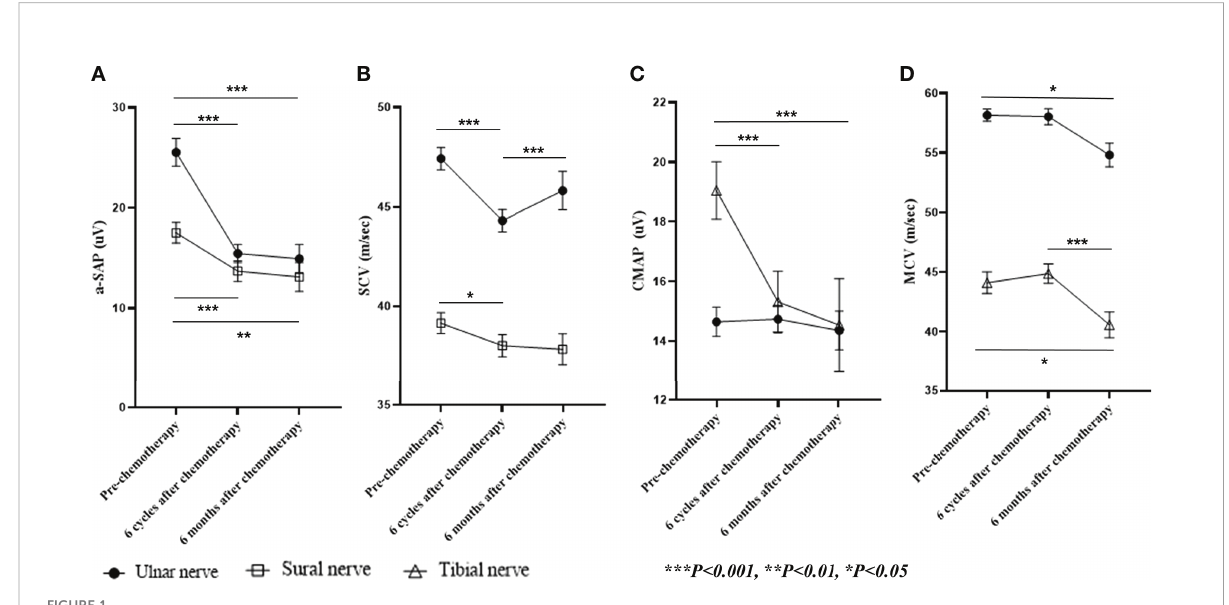
FIGURE 1 Nerve conduction studies. Shown are (A) a-SAP, (B) SCV in the ulnar and sural nerves, (C) CMAP, (D) MCV in the ulnar and tibial nerves during and six months after paclitaxel treatment. Data are presented as mean ± standard error. a-SAP, amplitude of the sensory nerve action potential;